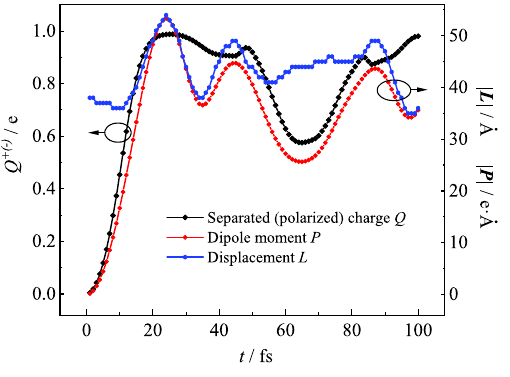
⇀ ⇀ L , polar torque P and quantity Q + ( − ) of the spatial-separated charge are time-